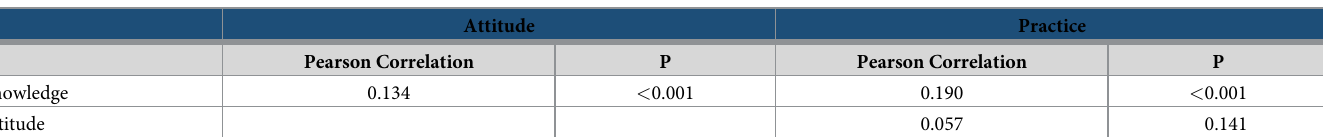
Table 2. Pearson correlations between